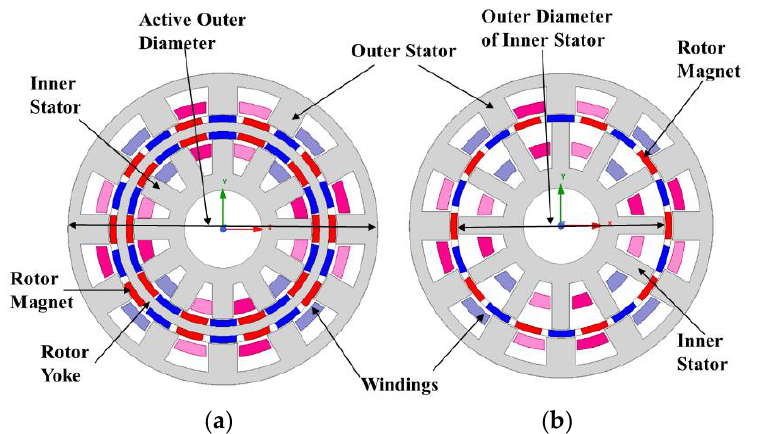
Figure 1. Dual airgap radial type PMVM topologies: ( a ) with iron yoke rotor, ( b ) without iron yoke (yokeless) rotor.